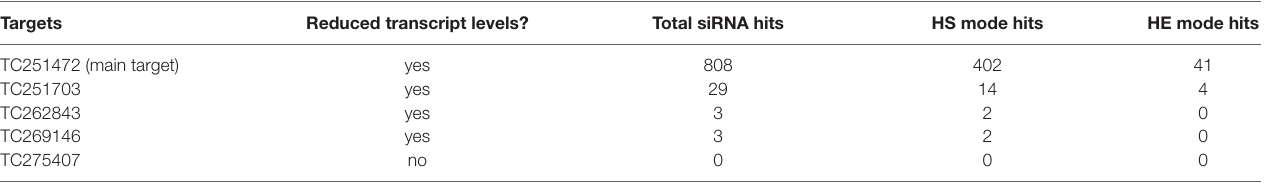
TABLE 3 | siFi analysis results of the potential off-targets of BTI1 RNAi construct from Xu et al. (2006). Targets Reduced transcript